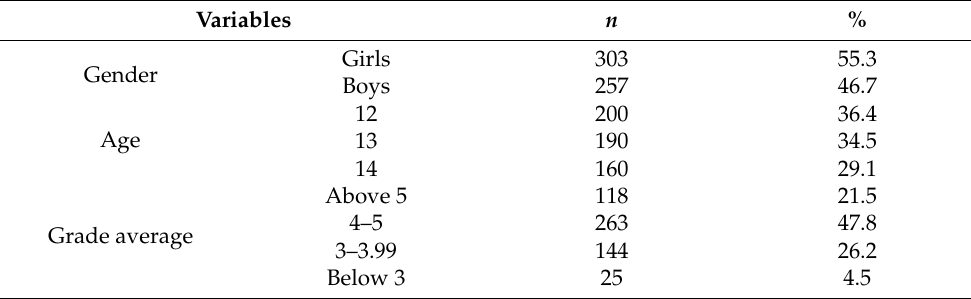
Table 1. Demographic characteristics of the